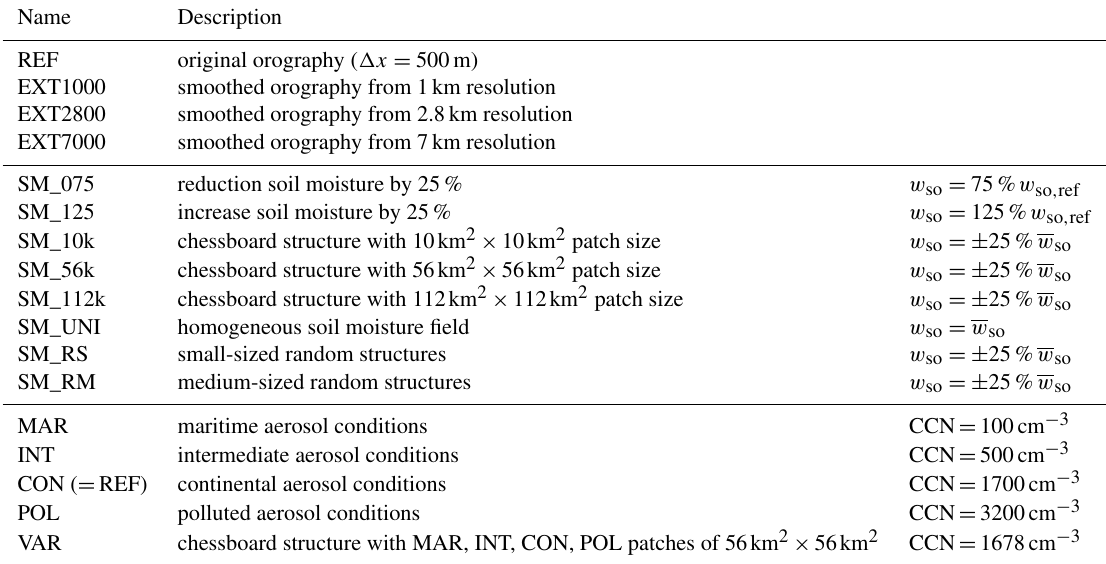
Table 1. Overview of the performed numerical sensitivity simulations. The reference run and all orography/soil moisture perturbations use a continental CCN assumption (CON). The relative soil moisture content w so is modified only at model initialization.